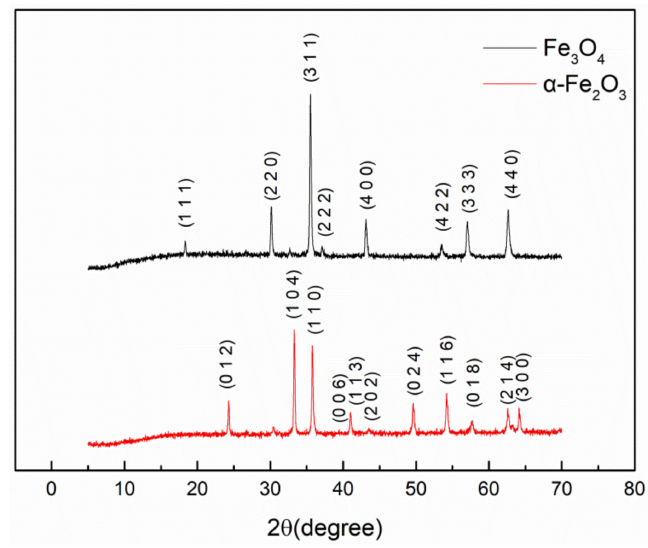
Figure 3. XRD patterns of Fe 3 O 4 and α -Fe 2 O 3 . Particles were indexed according to the standard of ICDS Cards, 74-0748 and 79-0007 for Fe 3 O 4 and α -Fe 2 O 3 , respectively.